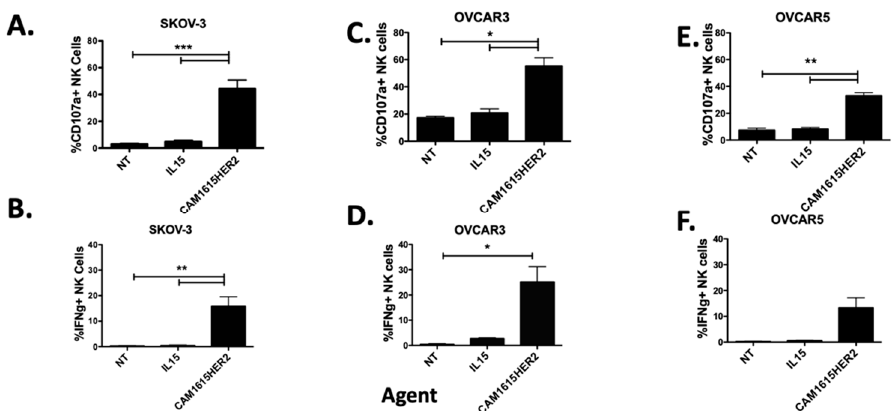
Figure 3. CAM1615HER2 TriKE mediates NK cell activation against ovarian cancer cell lines. To determine the ability of the CAM1615HER2 TriKE to induce NK cell activation against ovarian cancer cells, PBMCs were incubated with SKOV3 cells ( A , B ), OVCAR3 cells ( C , D ), and OVCAR5 cells ( E , F ) for 5 h with noted treatments (30 nM) and degranulation (CD107a: A , C , E ), and intracellular cytokine production (IFN γ : B , D , F ) was evaluated on NK cells by flow cytometry ( n = 4). NT = No treatment (NK alone) and IL15 = treatment with recombinant IL-15. Error bars display mean ± SEM, and statistical significance was shown as * p < 0.05, ** p < 0.01, and *** p < 0.001.